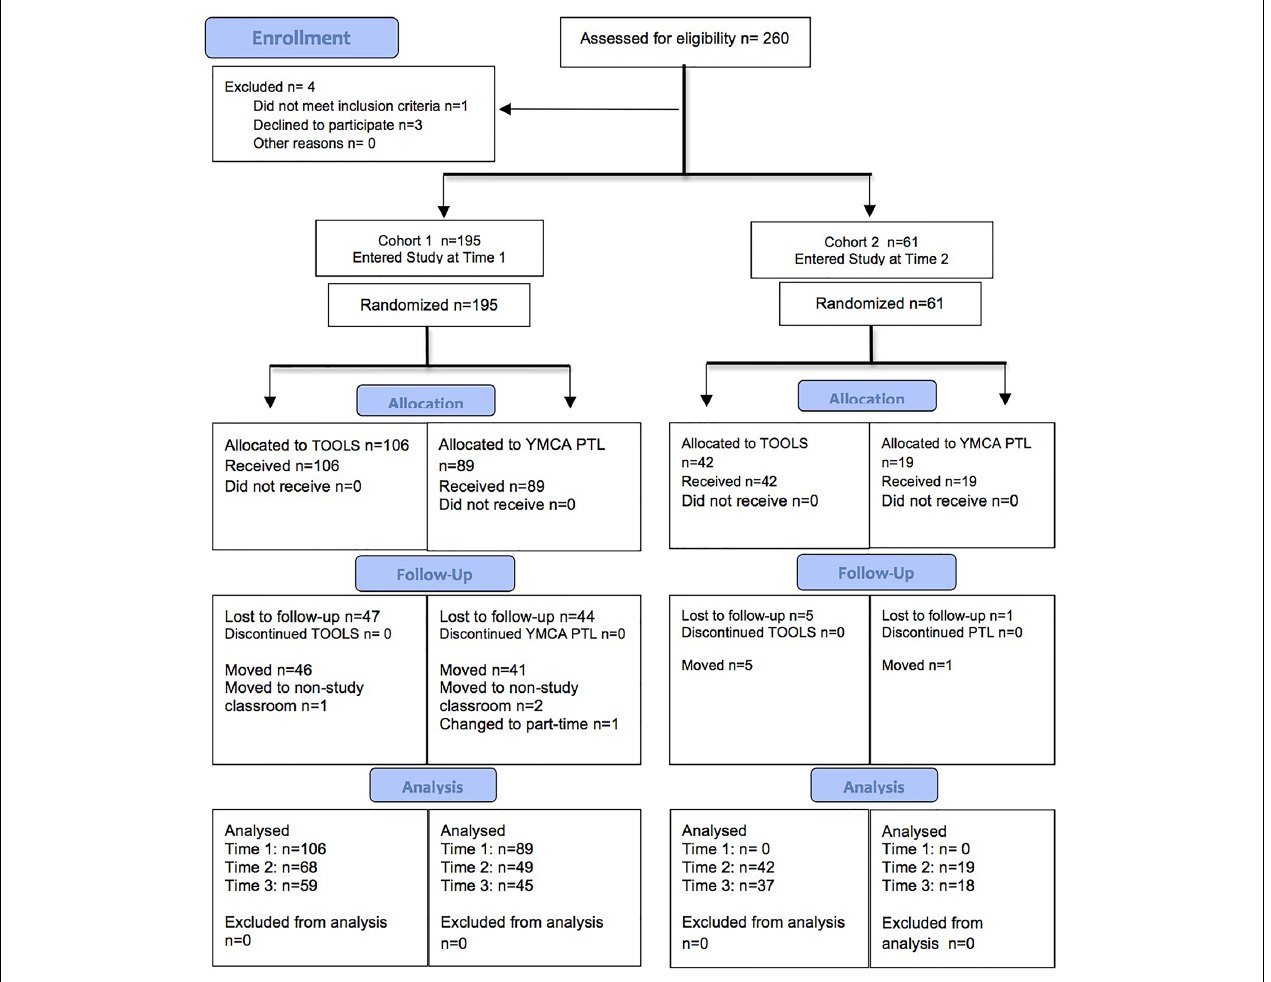
FIGURE 1 | Consort flow diagram of study